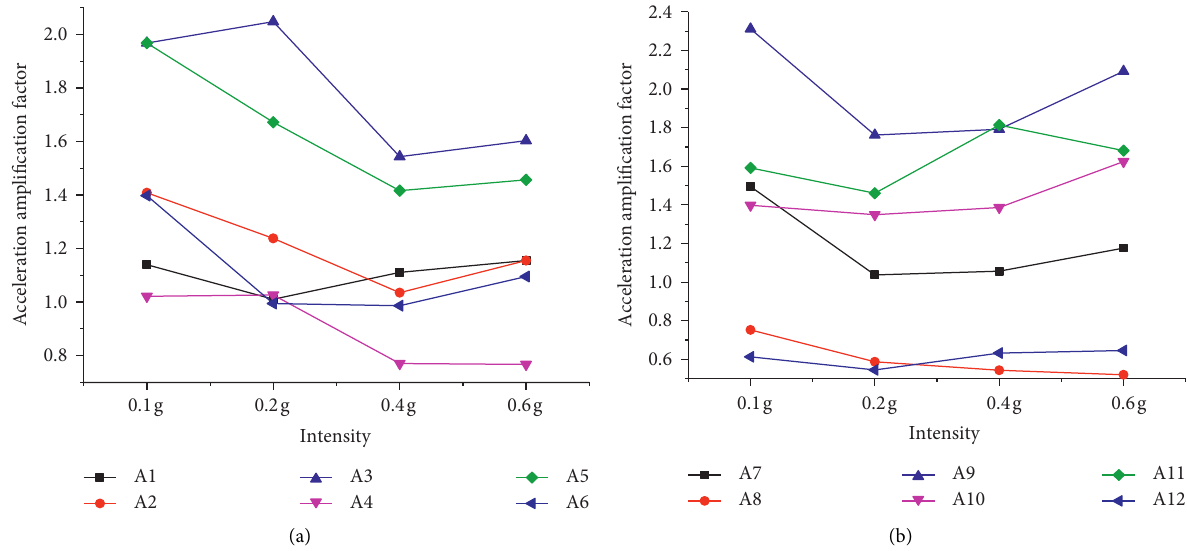
Figure 16: Variation trends of AAF of WC-XZ in the X -direction at different intensities: (a) left hole and (b) right hole.